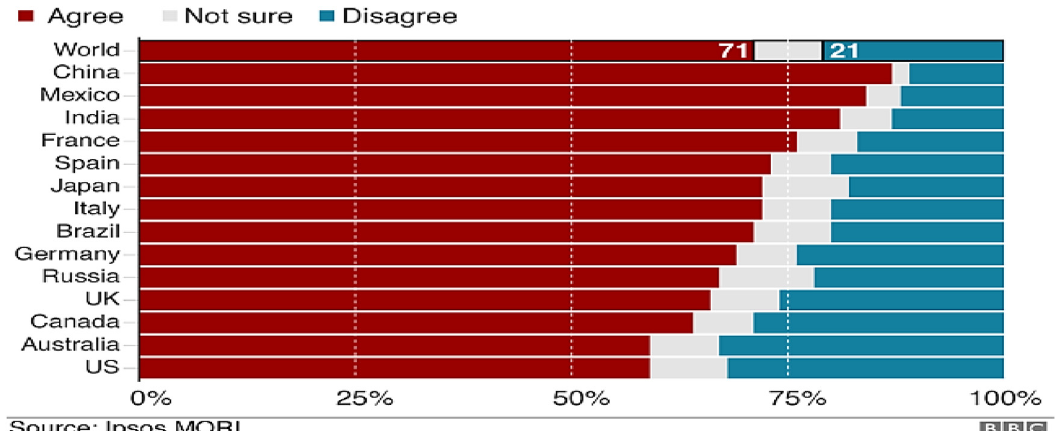
Fig. 1. Percentage of People who agree that, in the long term, climate change is as severe a crisis as